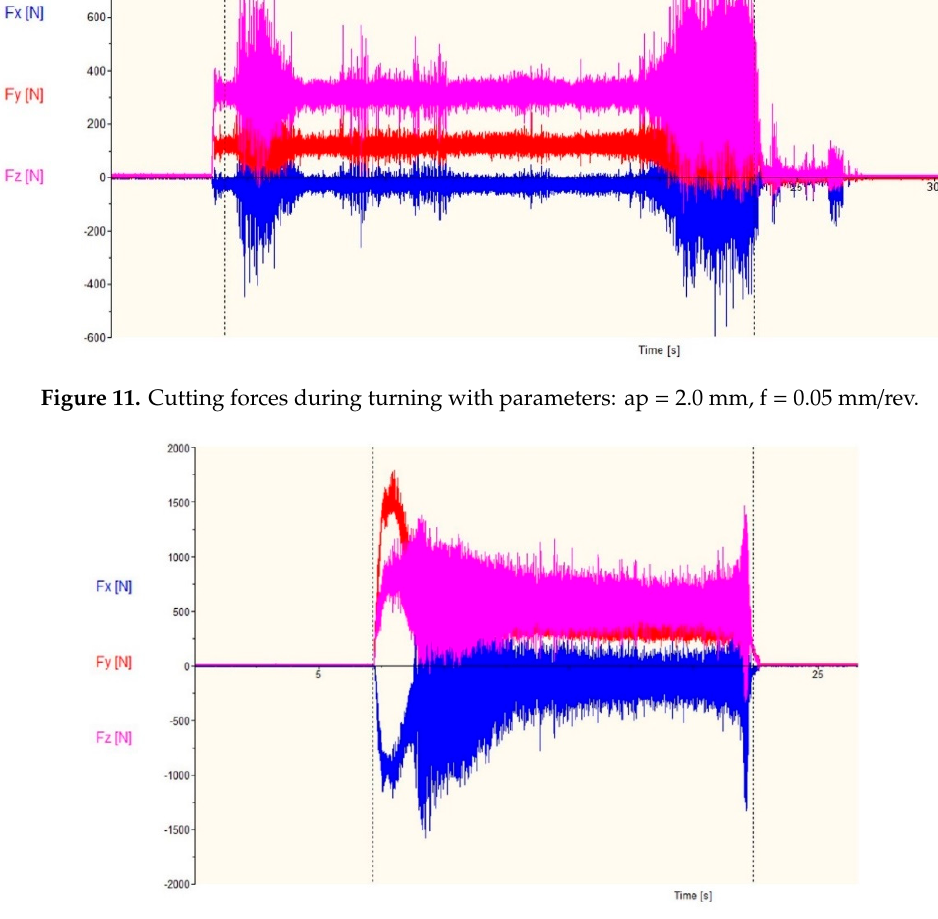
Figure 13. Cutting forces during turning with parameters: ap = 2.0 mm, f = 0.10 mm/rev. In order to properly carry out the turning process of stainless steel, it is important to ensure that in such cutting conditions, the chips produced during machining are short or in a controlled manner are discharged into the chip pan of lathe machine. Our work was carried out without the use of a cooling liquid, which also contributed to the formation of long chips. In Figures 11–13, single or periodically repeating peaks can be observed. The formation of a long chip that is not properly removed remains in the direct cutting zone. Jamming of chips between the tool and the workpiece results in the generation of single or periodic increases in forces during the cutting process. This situation may cause the heated chip to cut again, and the situation may lead to thermal overheating and even chipping of the cutting edge of the tool. In addition, a turning process was carried out using a new cutting insert with parameters: Vc = 250 m/min, ap = 2.0 mm and f = 0.1 mm/rev. Obtained results of measurements are presented in table 6. The turning process carried out in this way resulted in the registration of the values of the analysed forces close to three times more than that for the insert with the damaged cutting edge. Table 6. The results of cutting forces for ap = 2.0 mm, f = 0.1 mm/rev; recorded during turning by tool with a new insert.